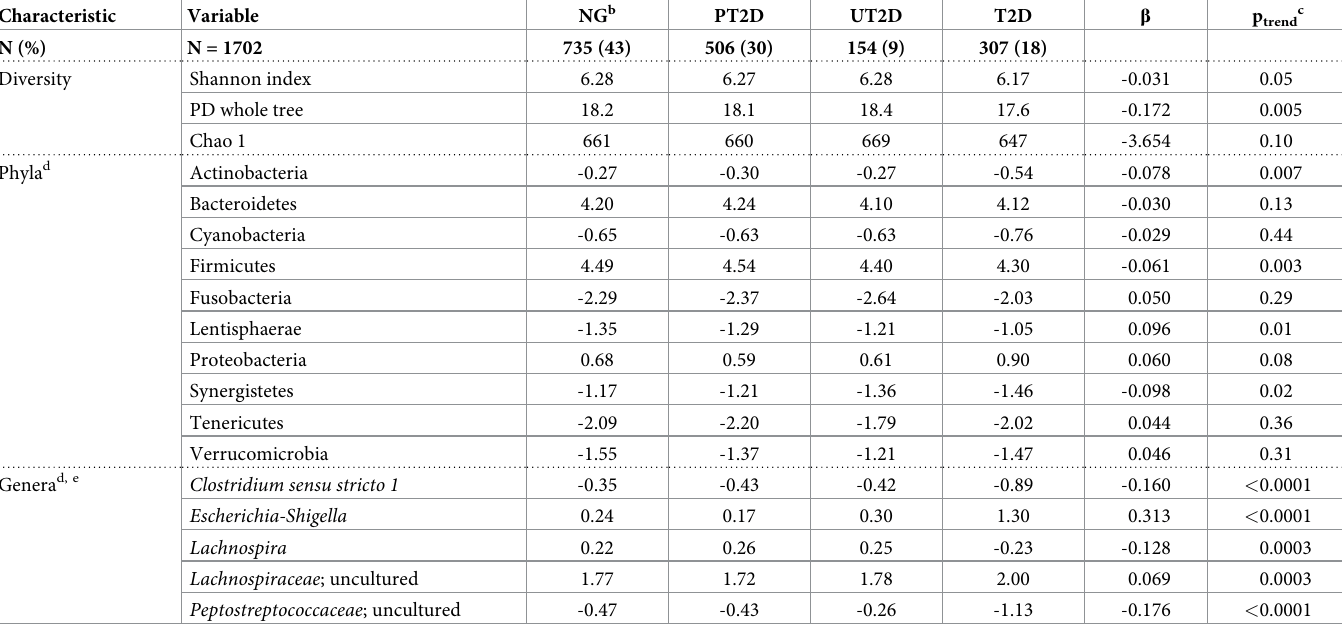
Table 2. Fecal microbial diversity and structure in relation to diabetes status, APS, 2013–2016 a .